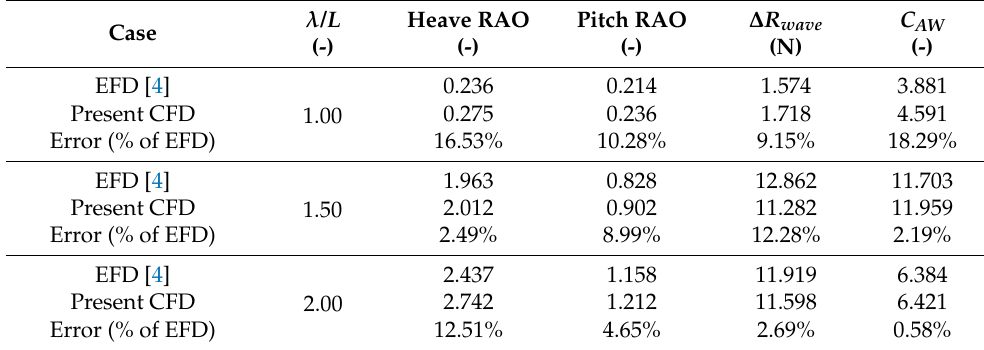
Table 5. Comparison of the seakeeping tests in regular waves for Delft 372 catamaran at Fr =